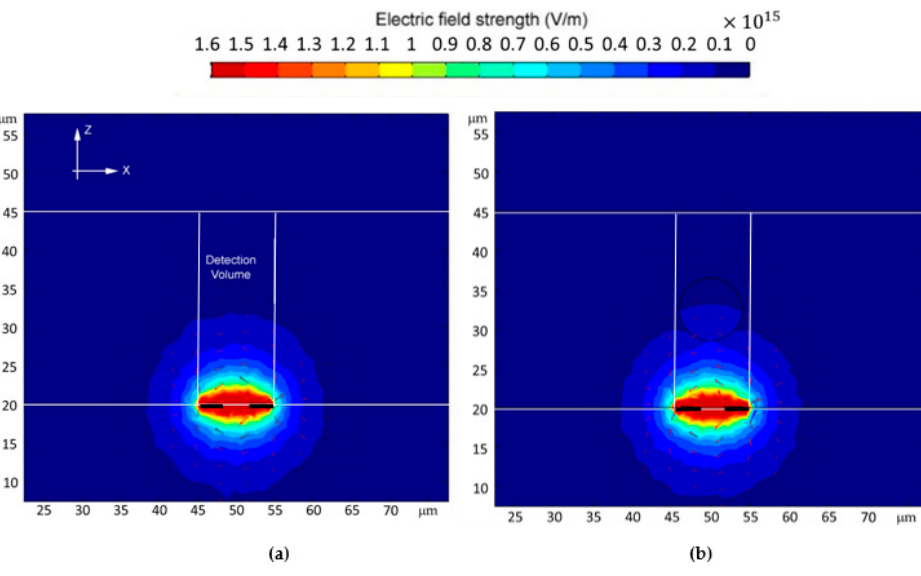
Figure 8. Electric field strength in the detection volume with and without 8 μ m RBC in 25 μ m micro- fluidic channel for; ( a , b ) 1D IDC ( c , d ) 2D PPC.